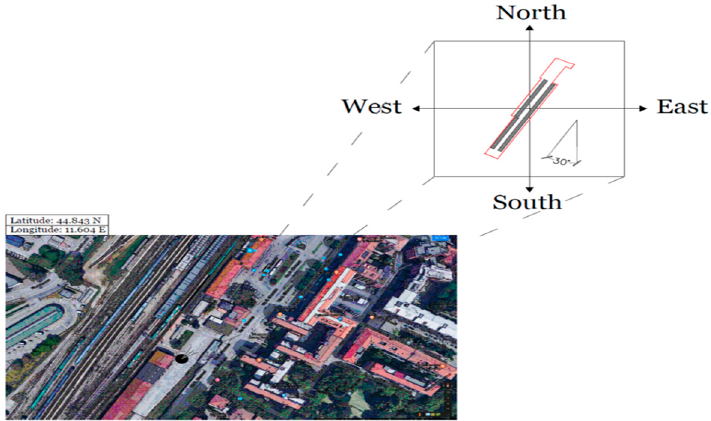
Figure 11. Bird-eye view for the site of interest—the car park.